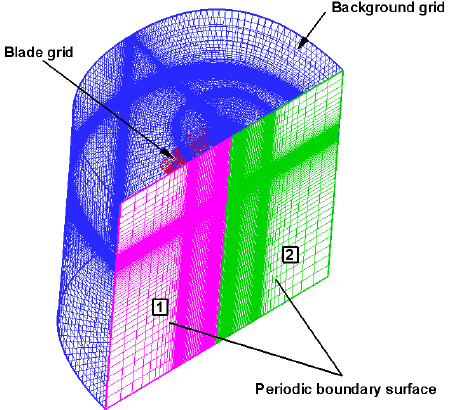
Figure 7. Sketch of the chimera grid system and periodic boundary conditions.